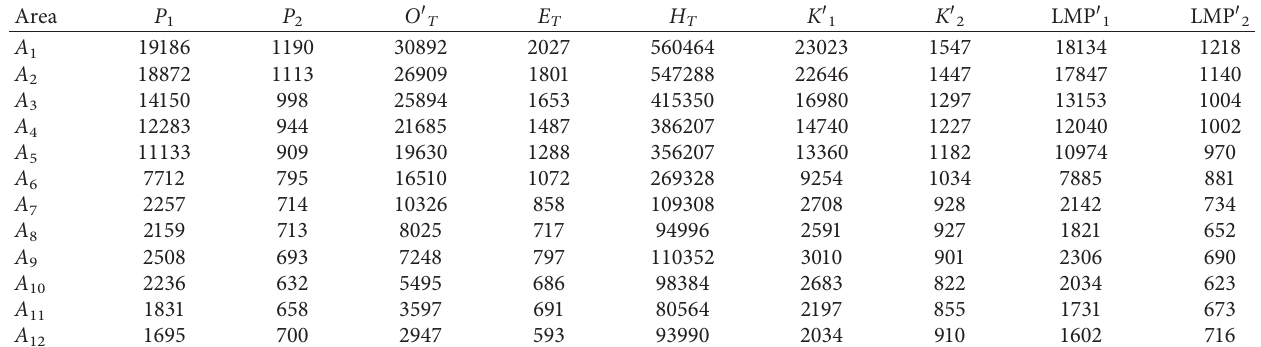
Table 6: Result of the robustness